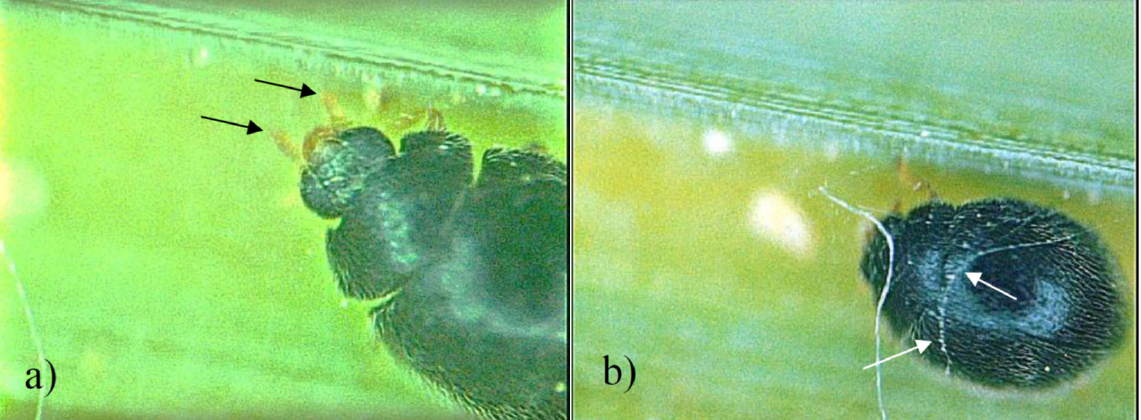
Figure 1. The specialist mite predator Stethorus gilvifrons coping with the web of the date palm mite, Oligonychus afrasiaticus : ( a ) using palp and mandibles to cut silk threads; ( b ) forced entry through forward thrust movement as depicted by web threads over the body. Black arrows represent the use of mandibles, while white arrows represent the web roof being dragged and ruptured by the forced movement.